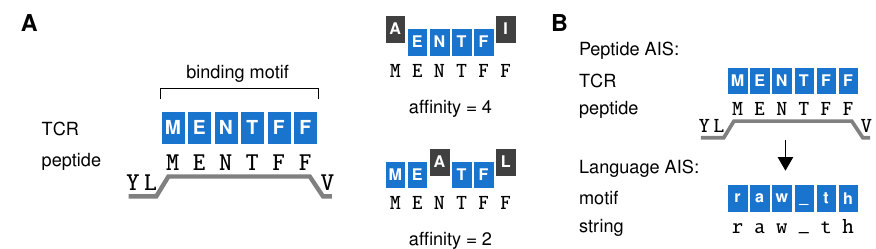
Figure 2. An artificial immune system model of a T cell repertoire. ( A ) Our artificial immune system (AIS) represents TCRs by a binding motif —the peptide sequence they bind to most strongly (left). Since TCR binding to peptides on MHC-I (HLA-A2:01) focuses on the six residues at positions 3–8 of